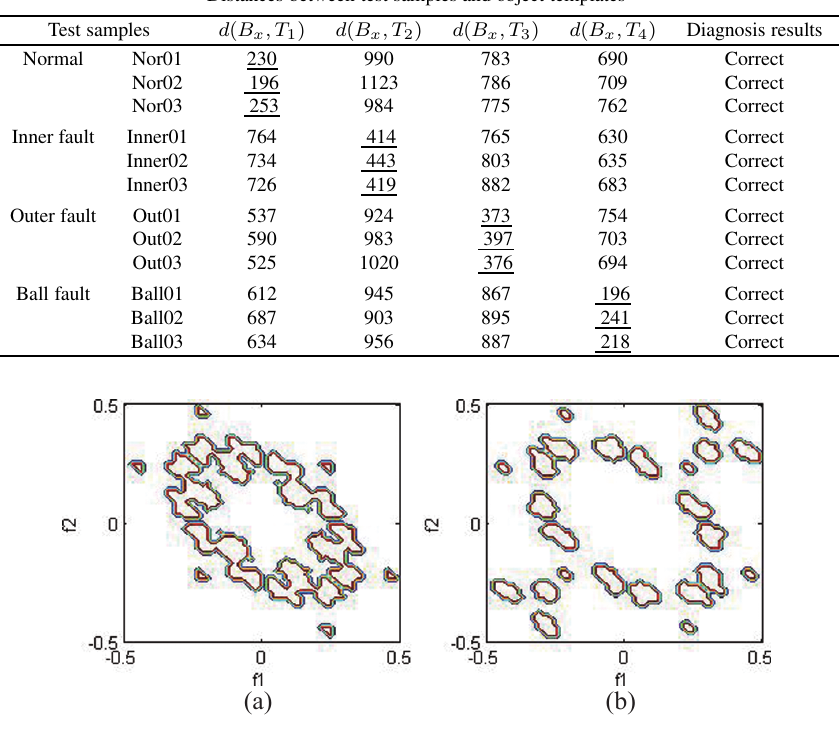
Fig. 7. Domain images of object template (a) Inner fault domain image (b) Ball fault domain